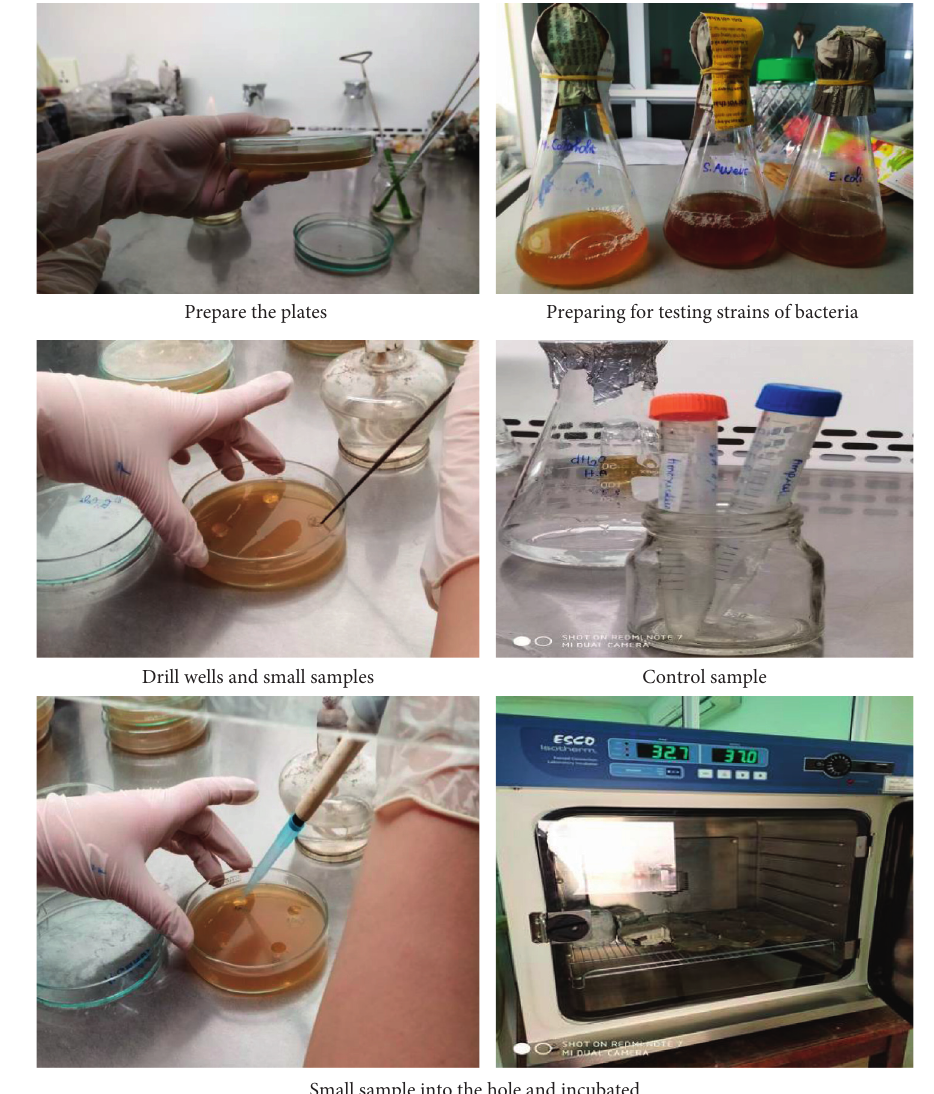
Figure 1: Steps to determine antibacterial